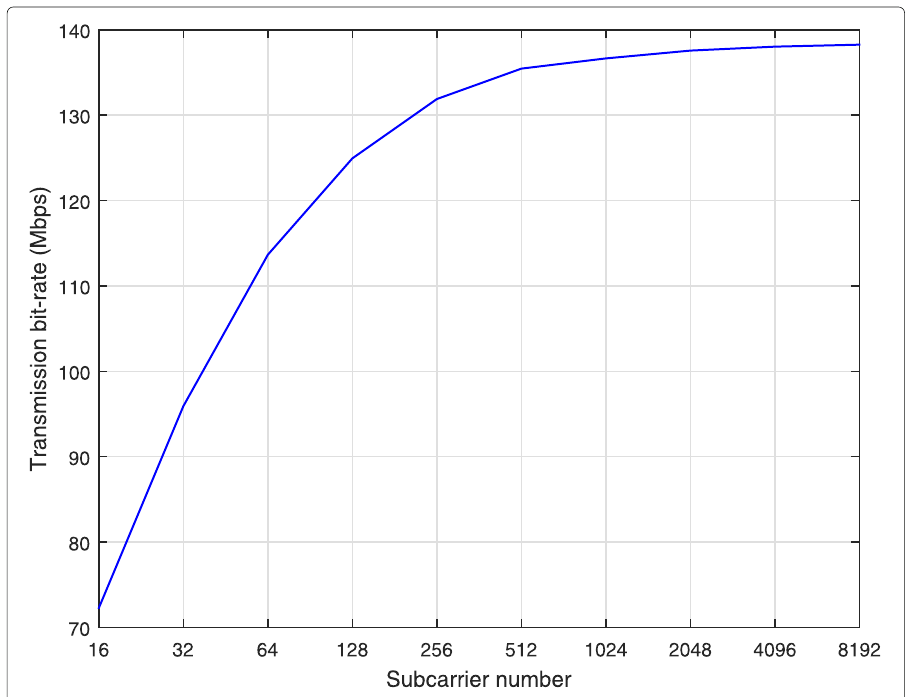
Fig. 10 System transmission bit rate with different subcarrier number